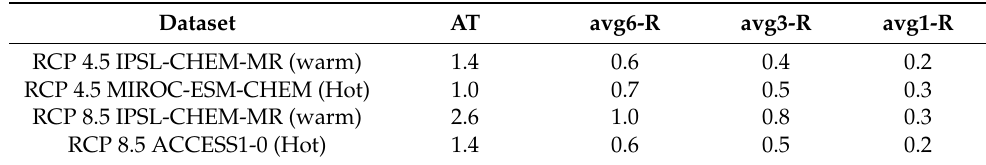
Table 17. Effects of ambient temperature on water temperature for Roode Elsberg dam from 2012–2053 at different RCPs, full dam steady state.